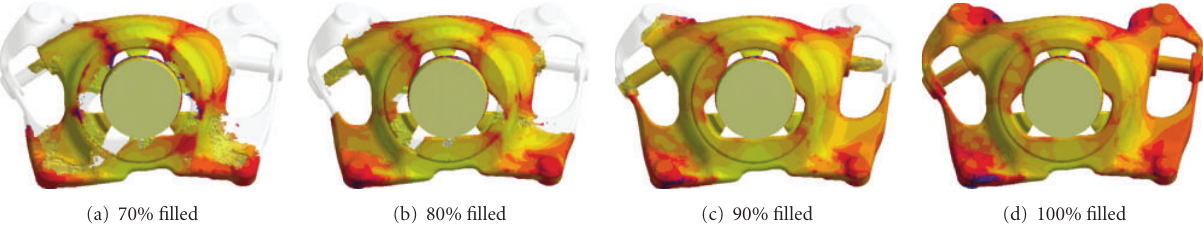
Figure 14: Filling behavior of module bracket by rheology forging.